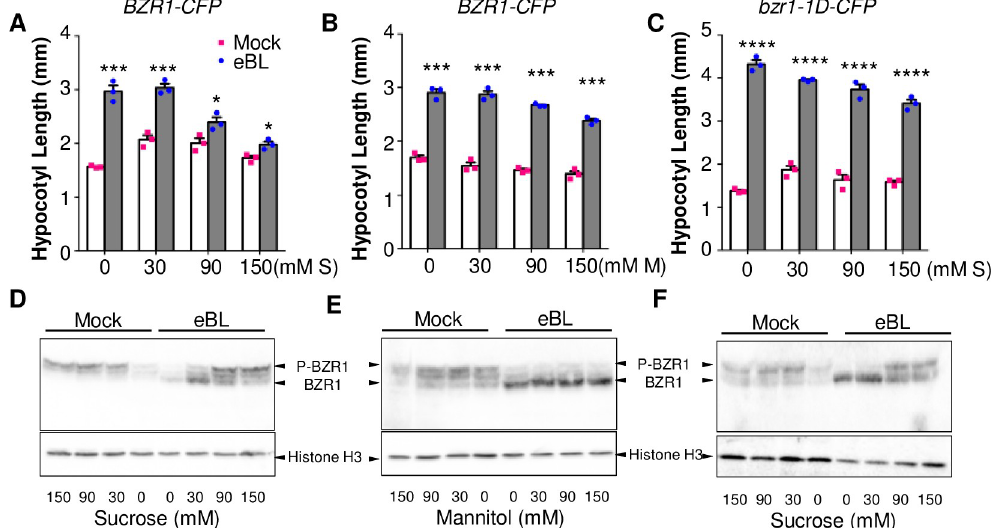
Fig 1. Sucrose inhibits the BR-induced hypocotyl elongation and dephosphorylation of BZR1 in light. (A-B) Hypocotyl length of transgenic Arabidopsis seedlings expressing BZR1-CFP (A and B) or bzr1-1D-CFP (C) grown on medium containing 100 nM epi-brassinolide (eBL) and various concentrations of sucrose (A and C) or mannitol (B). ���� P < 0.0001, ��� P < 0.001, � P < 0.05 (Student’s t test). Error bars indicate the standard error of the mean (SEM, three replicates). (D-F) Immunoblot analysis of BZR1-CFP protein in the same batches of seedlings as in penal A to C. Histone H3 was probed as a loading control. P-BZR1 indicates phosphorylated BZR1; BZR1 indicates dephosphorylated BZR1. S, sucrose; M,